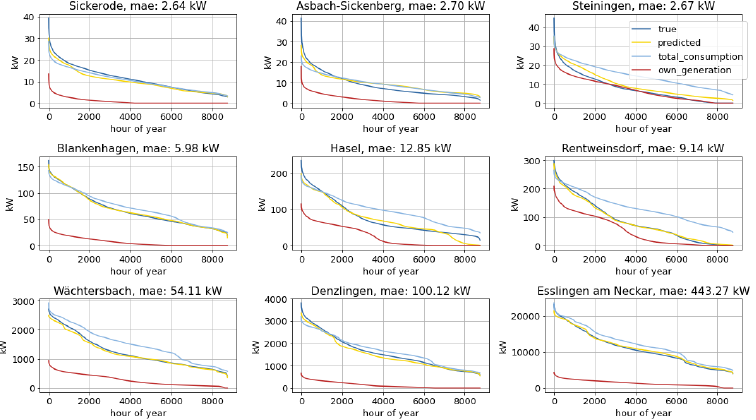
Figure 14. Supply duration curves for nine municipalities of different sizes, including the ground